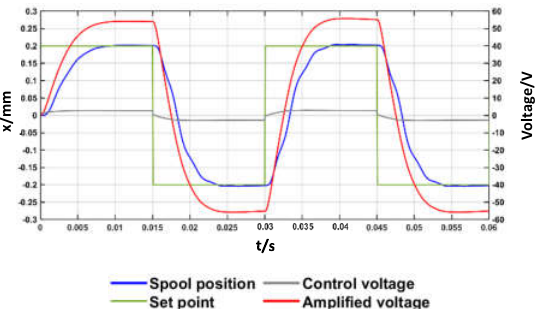
Figure 10. Simulated closed-loop step tests ± 0.2 mm ( p p − p T = 70 bar, C p = 90 Ns/m, m p = 80 g; ω n , a = 1400 rad/s).